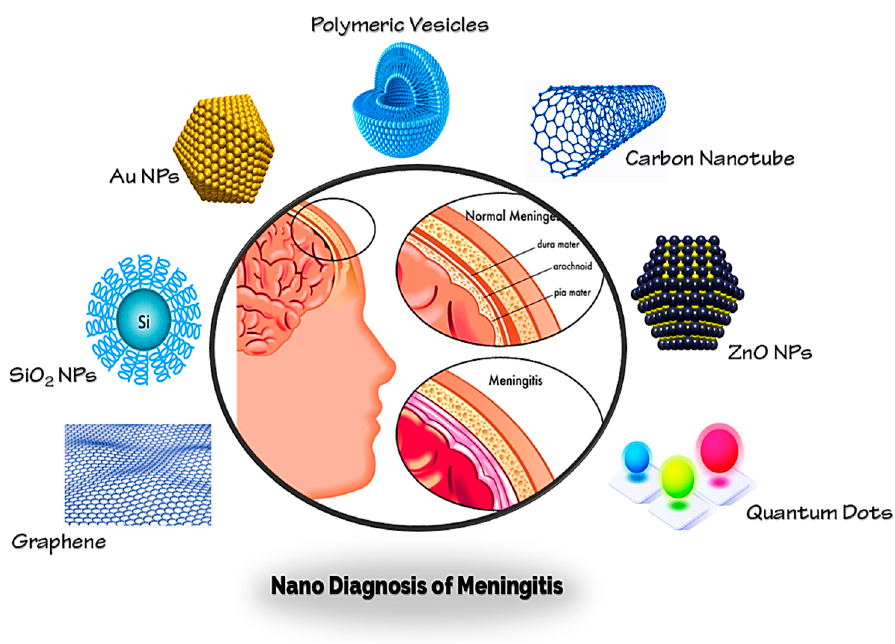
Figure 4. Different nanoparticles for detection of brain infection and meningitis.